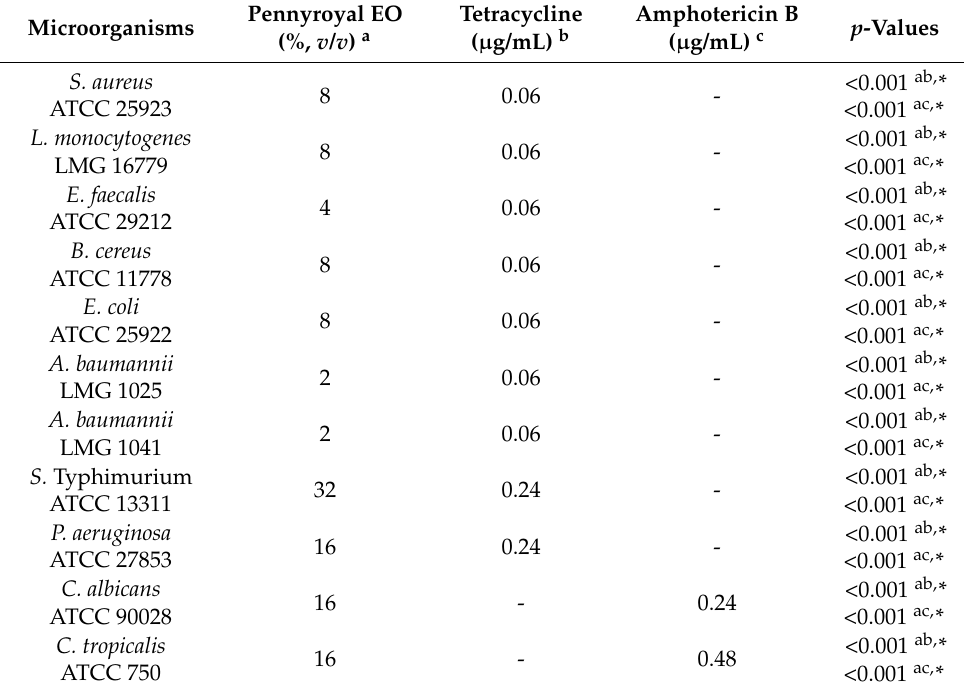
Table 4. Minimum inhibitory concentrations (MICs) and minimum lethal concentrations (MLCs) of pennyroyal